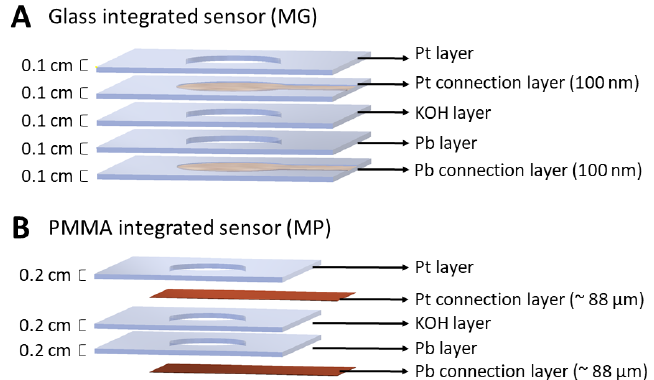
Figure 1. ( A ) Model of Glass-integrated sensor (MG); ( B ) Model of Polymethylmethacrylate